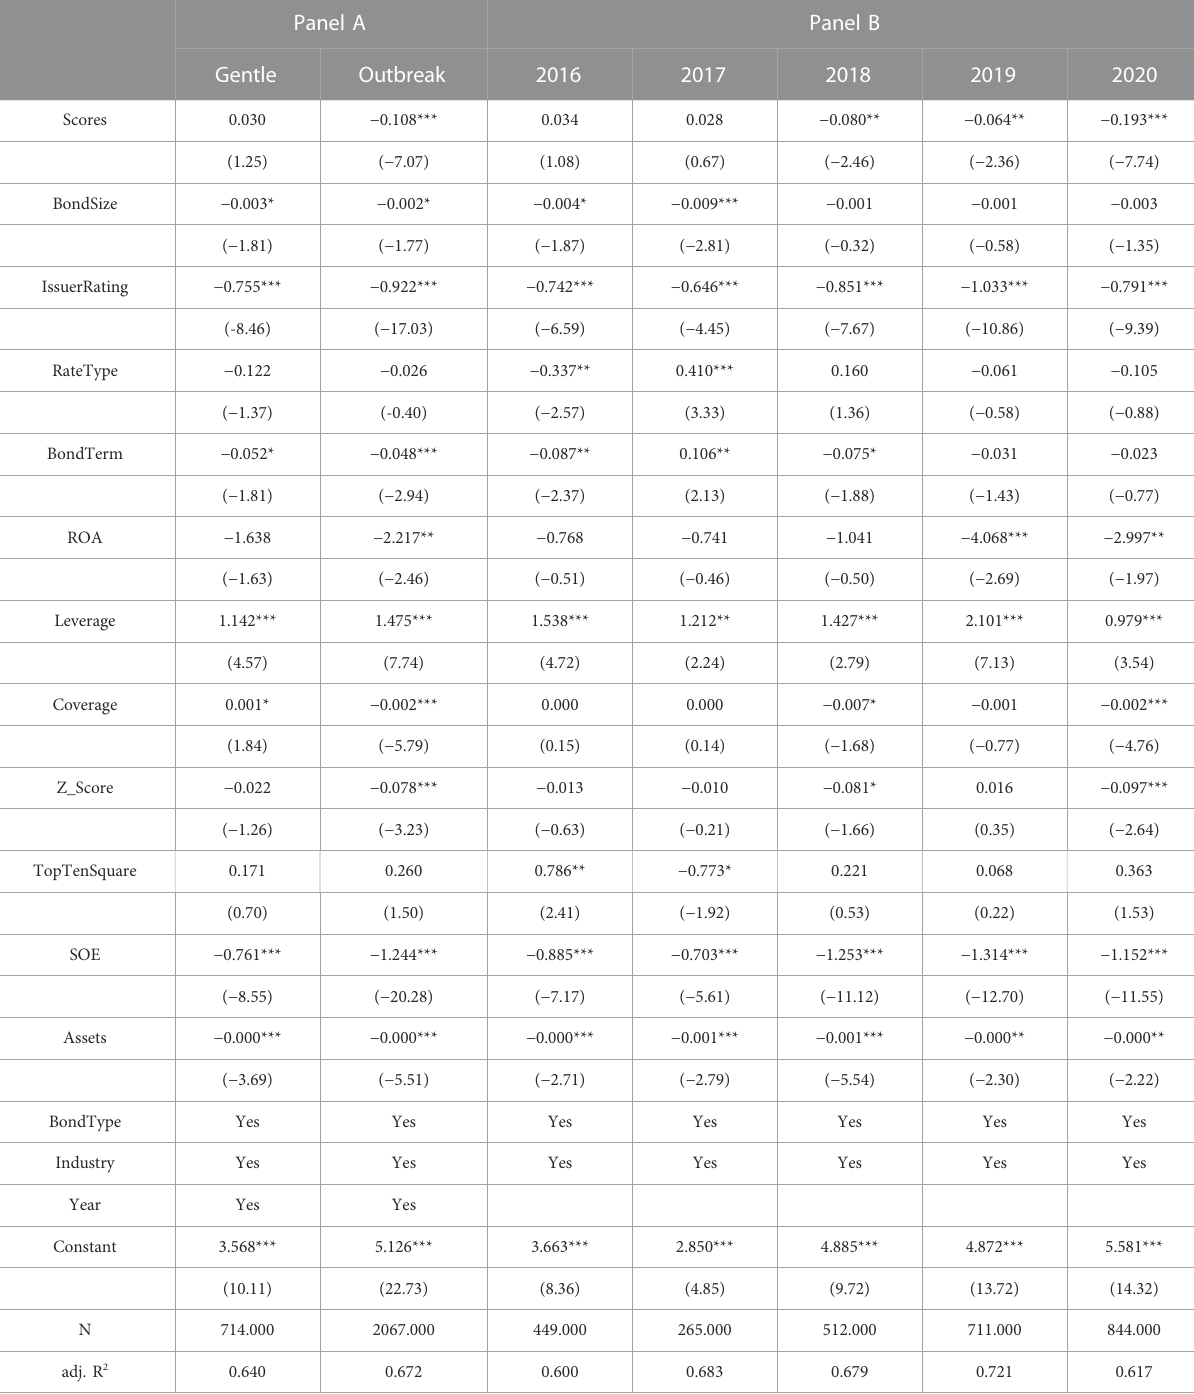
TABLE 9 Annual trend change